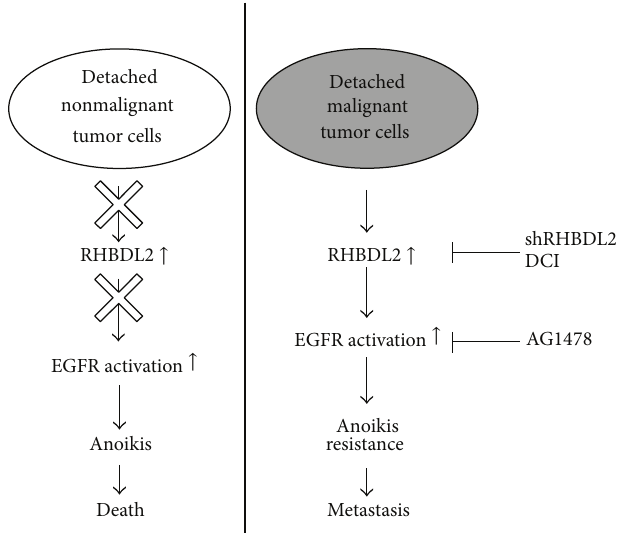
Figure 5: Schematic diagram of RHBDL2 in regulation of anoikis resistance in malignant tumor cells. As shown in right panel, detached malignant tumor cells obtain anoikis resistance through the upregulation of RHBDL2 and activation of